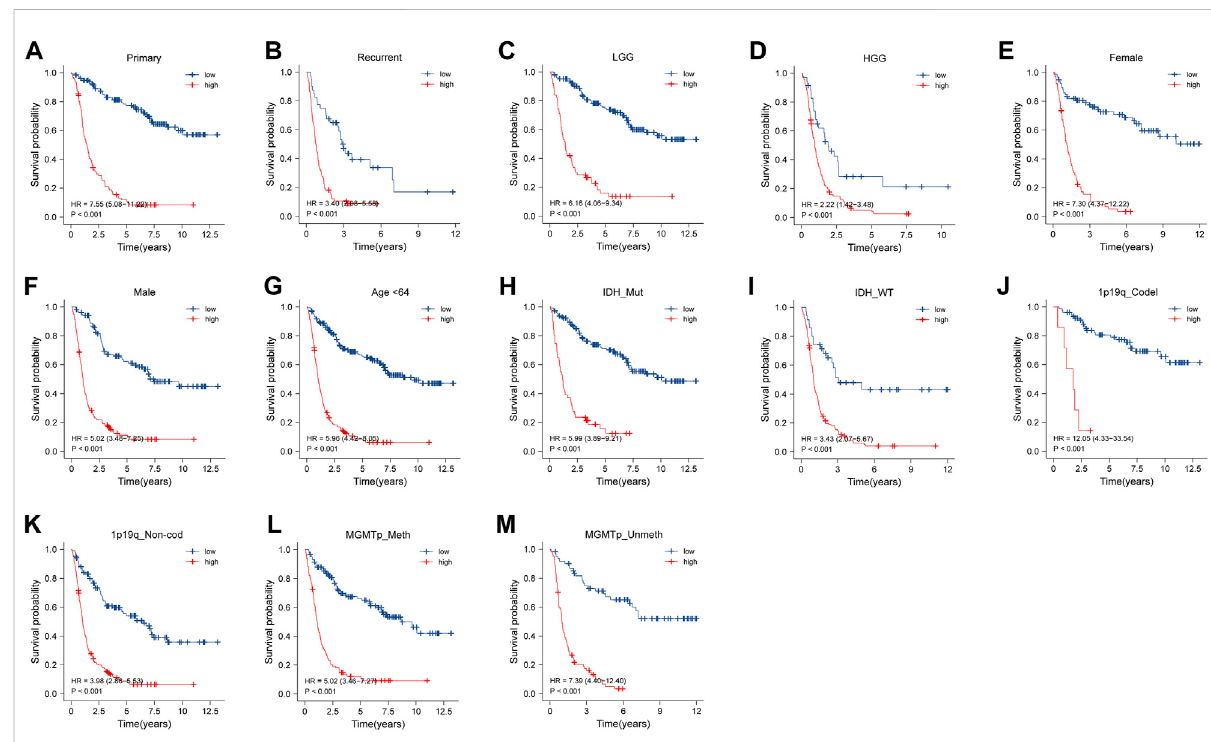
FIGURE 3 Strati fi ed survival analysis of high- and low-risk score patients in the training cohort by PRS type (primary and recurrence), grade, sex, age, IDH mutant status, 1p/19q codeletion status, and MGMT promoter methylation status (A – M)